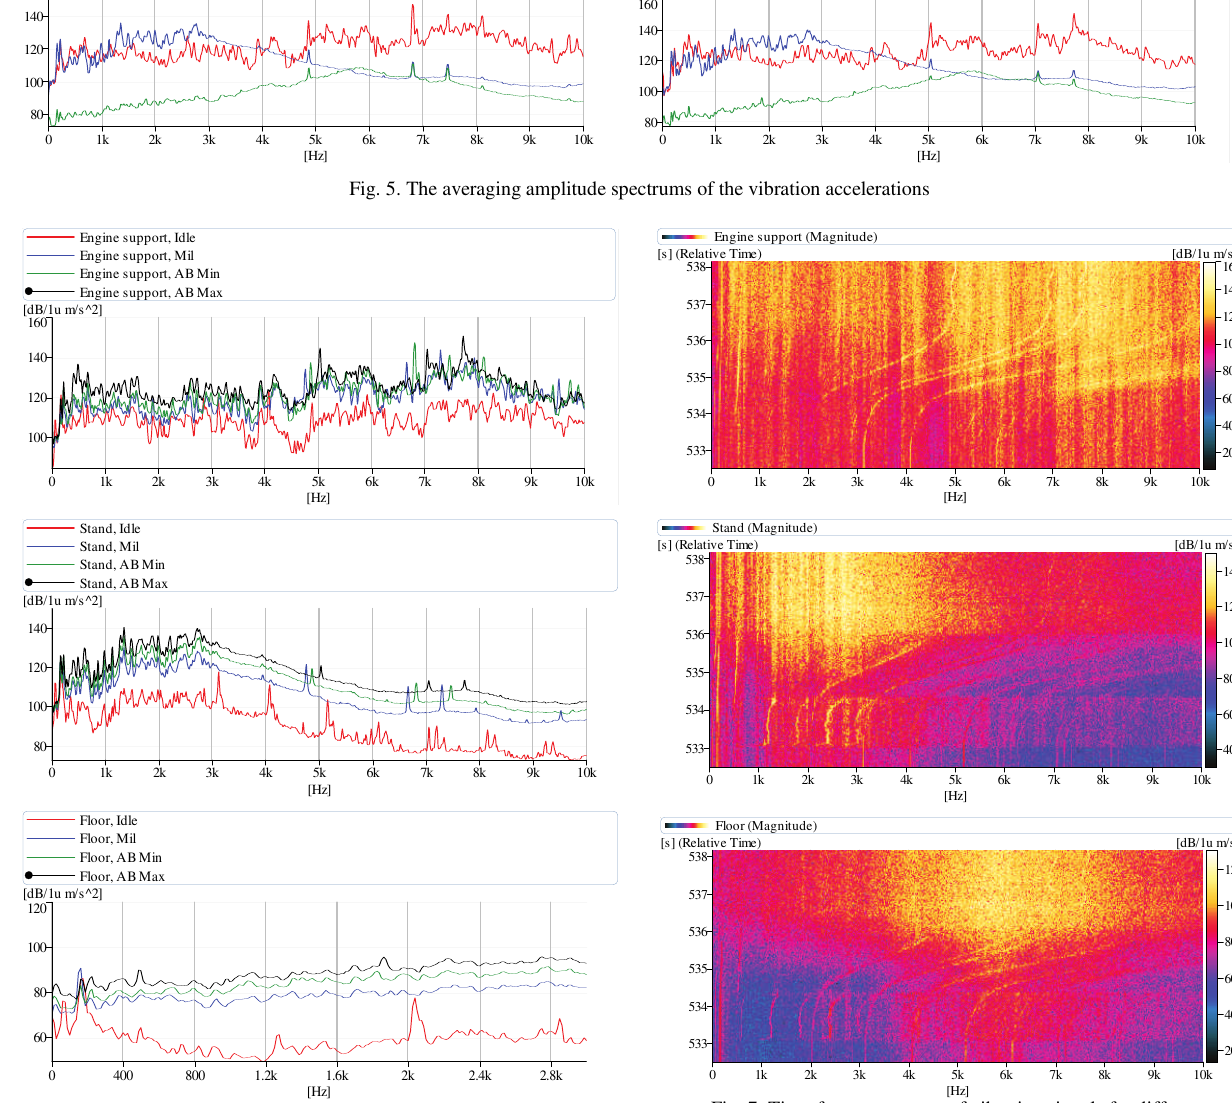
Fig. 6. The averaging amplitude spectrums of the vibration accelerations Figure 6 shows the average amplitude spectrum of vibration acceleration signals recorded at three different measurement points. In this illustration the results are grouped by measurement points. test from Idle to AB Max is shown in Figure 7. Visible frequency changes in time are the result of changes in the revolution speed of the engine shaft.